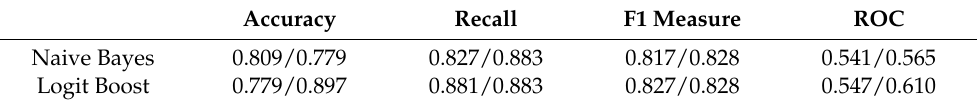
Table 8. Performance indicators obtained by the classification algorithms using 4